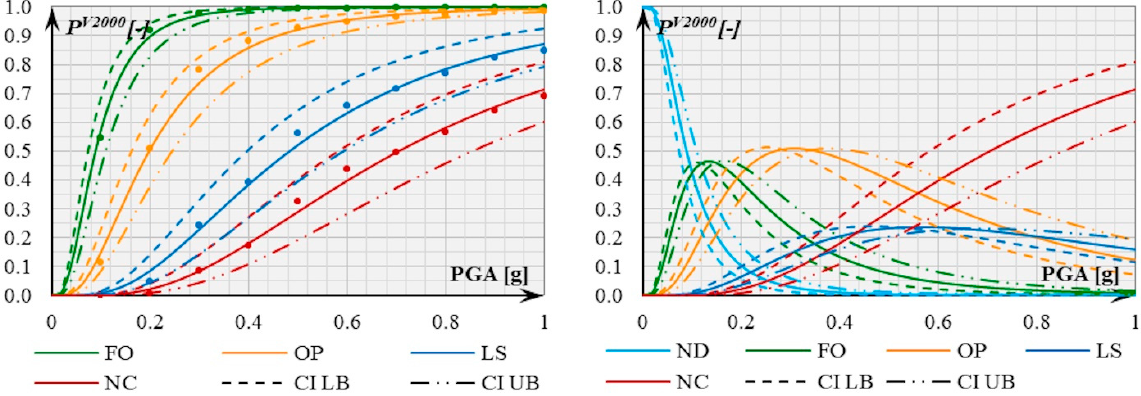
Figure 19. Fragility curves and probability density functions for the occurrence of different states of damage, according to VISION 2000 [33].